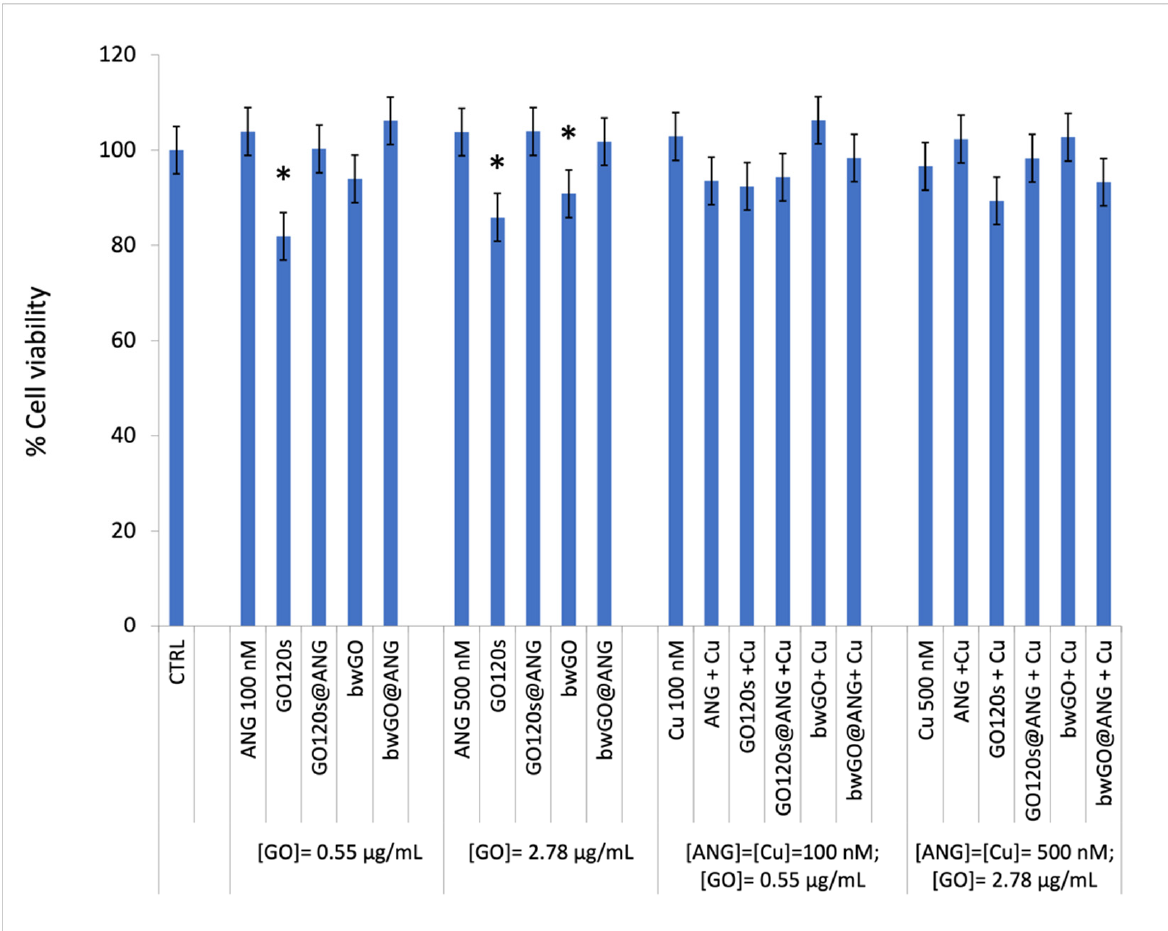
Figure 3. Cell viability of PC-3 cells after 24 h of treatment with the ANGAF488 protein (100 and 500 nM), GO120s or bwGO (0.55 and 2.78 μ g/mL) and the corresponding GO@ANG nanohybrids, in the absence or presence of CuSO 4 -supplemented medium (copper concentrations of 100 and 500 nM, with metal/protein molar ratio = 1). (*) p < 0.05, vs. CTRL. (Student’s t-test).